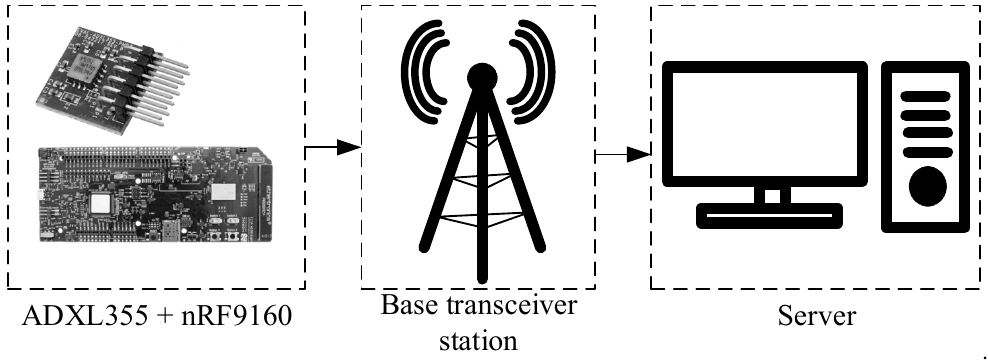
Figure 6. General scheme of signal transmission from an on-site sensor to an off-site server.